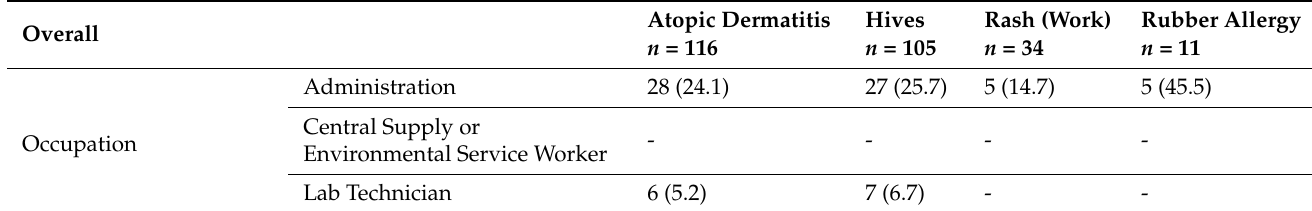
Table 6. Skin disorders and rubber allergy distribution by participant characteristics, N